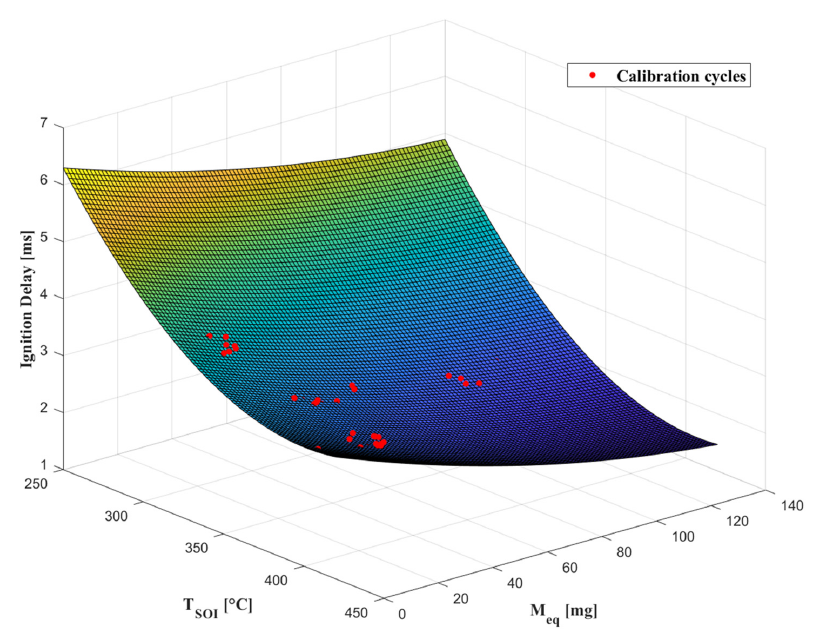
Figure 17. Control-oriented ID model.